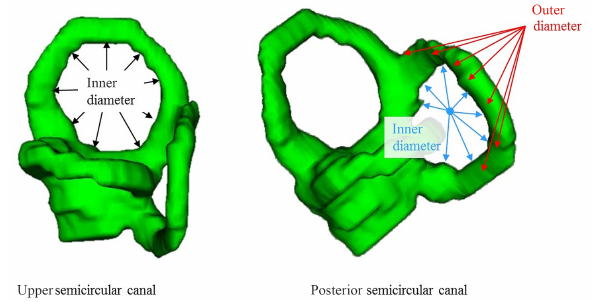
Figure 2. Uncertainty components along the minimal distance d between a sensitive structure and the drilling trajectory.